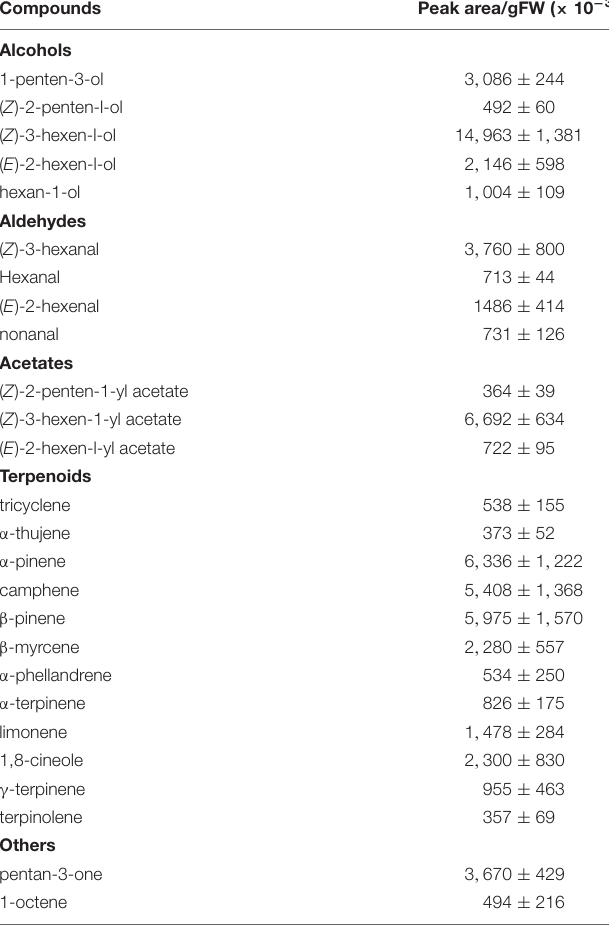
TABLE 1 | The volatile organic compounds in the headspace of artificially damaged weed.